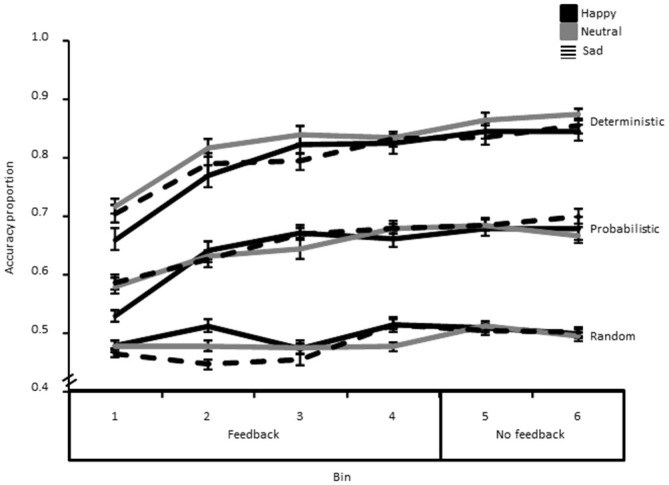
Accuracy data (i.e., proportion of correct responses) decomposed as a function of bin, probability and group. The error bar corresponds to one standard error of the mean.